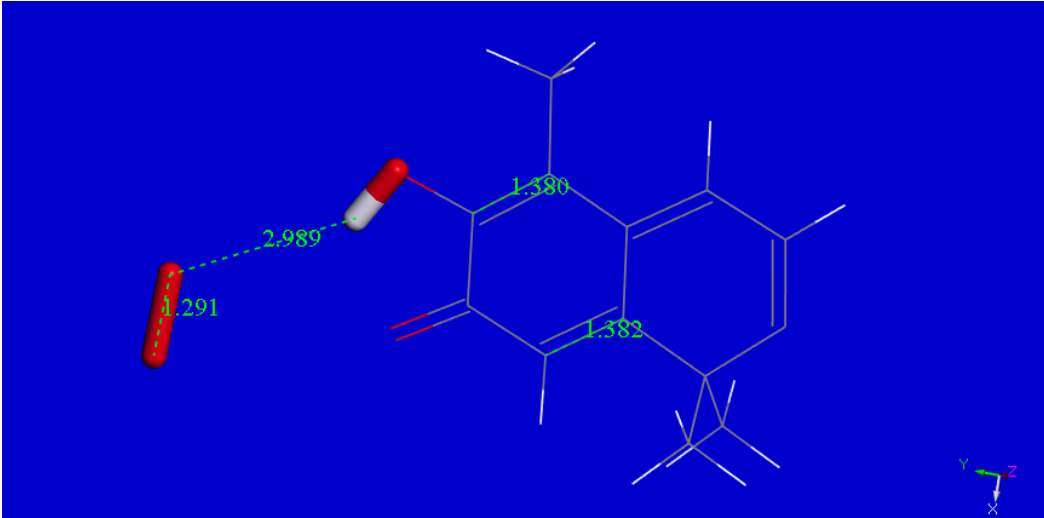
Figure 7. Superoxide σ approached by model celastrol, final state obtained after geometry optimization. The capture of the superoxide electron causes the double C-C bond in the ring to become lengthened (1.380 Å and 1.382 Å); the O 2 molecule separates from celastrol (2.989 Å), and the former superoxide has shortened its O-O bond, 1.291Å, compared with the initial state distance, 1.373 Å. This process does not involve H(hydroxyl) cleavage, as commonly happens for scavenging by polyphenols.